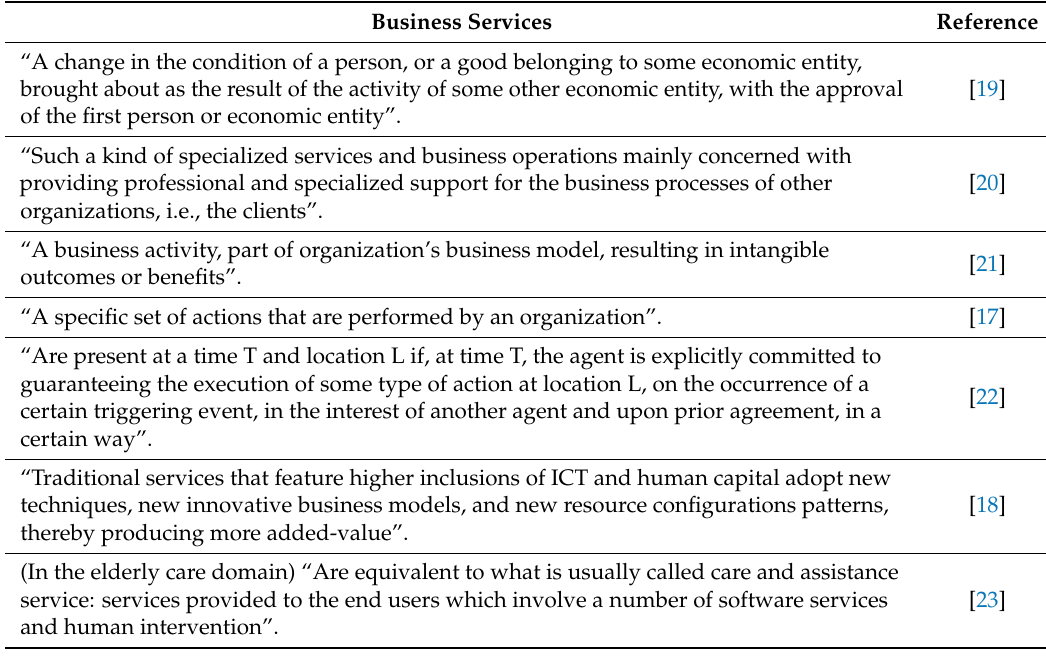
Table 1. Business Service